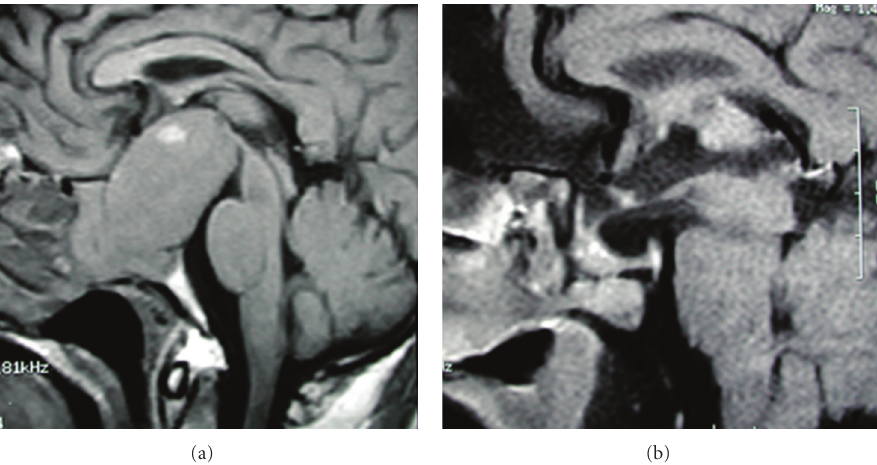
Figure 5: Enhanced MRI sagittal view that shows a giant pituitary adenoma reaching the third ventricle. Considering the uniform shape of the tumor, it could be removed through TS approach. (a) Preoperative view and (b) postoperative result.